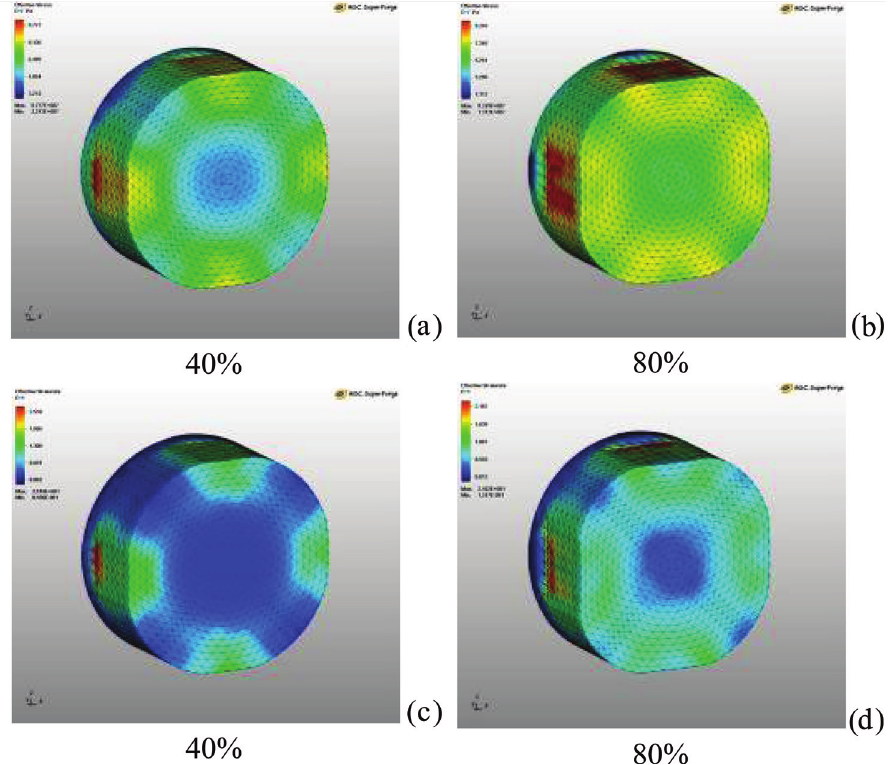
Figure 8: Picture of tension intensity distribution (a and b) and deformations (c and d) in workpiece when forging on RFM, t ¼